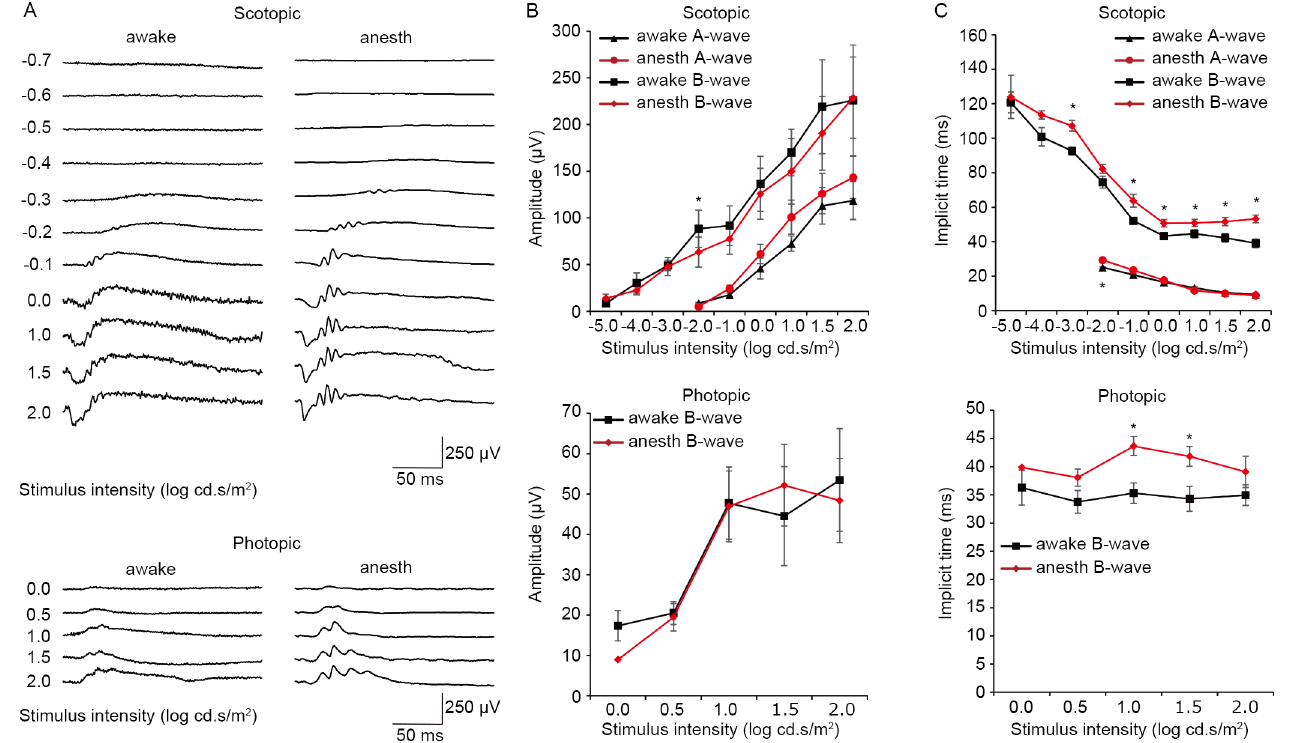
Fig 2. Awake and anesthetized ERG from the same mice. A. Representative traces of scotopic (top) and photopic (bottom) ERGs recorded from the same mouse in the awake (left) and anesthetized (right) condition. B. Amplitudes of scotopic (top) and photopic (bottom) ERG waves from the same mice recorded in awake (black) and anesthetized (red) conditions. C. Implicit times of scotopic (top) and photopic (bottom) ERG waves from the same mice recorded in awake (black) and anesthetized (red) conditions. * P < 0.05. Data from seven mice. The bars indicate mean ± standard error of the mean (S.E.M). anes: